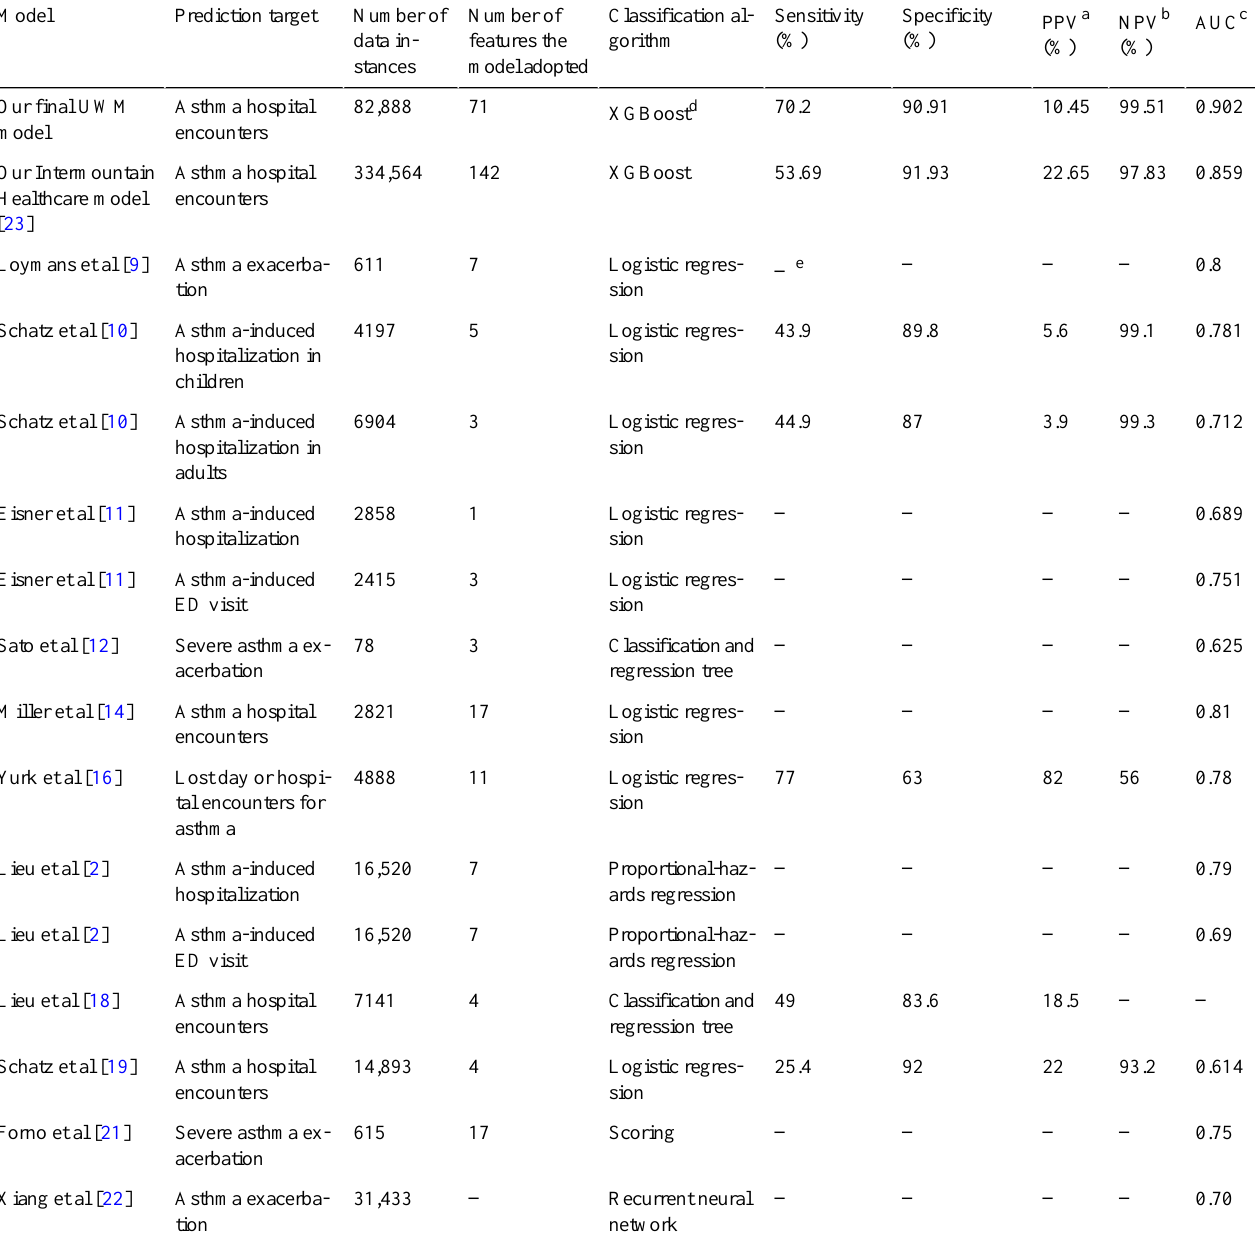
Table 7. A comparison of our final University of Washington Medicine model and several existing models for forecasting future hospitalizations and emergency department (ED) visits of patients with